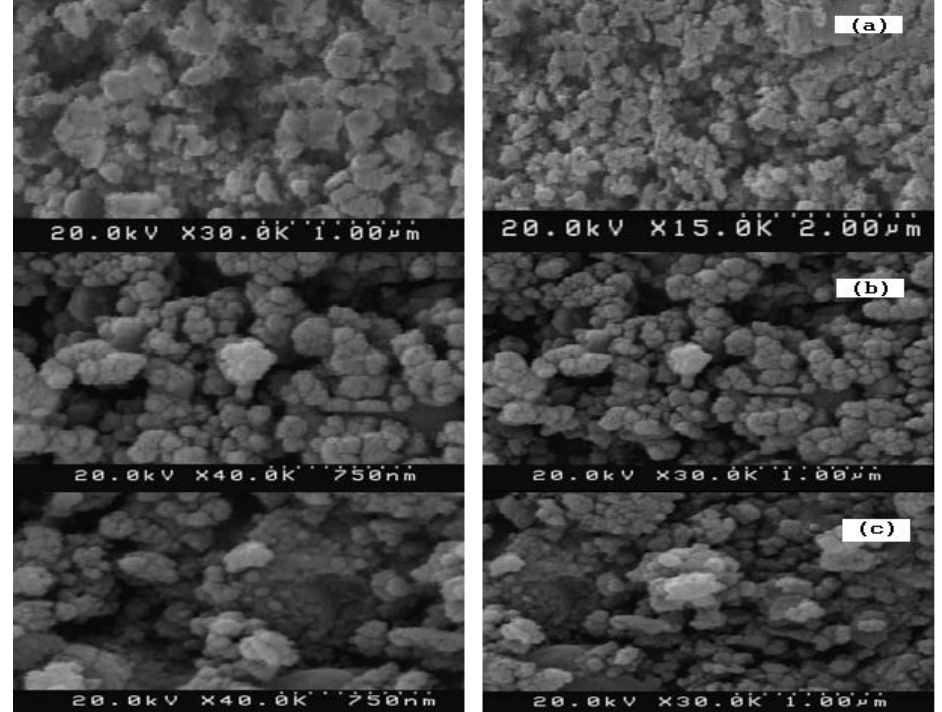
Fig. 2: SEM photograph of Cu (b)x=0.25,